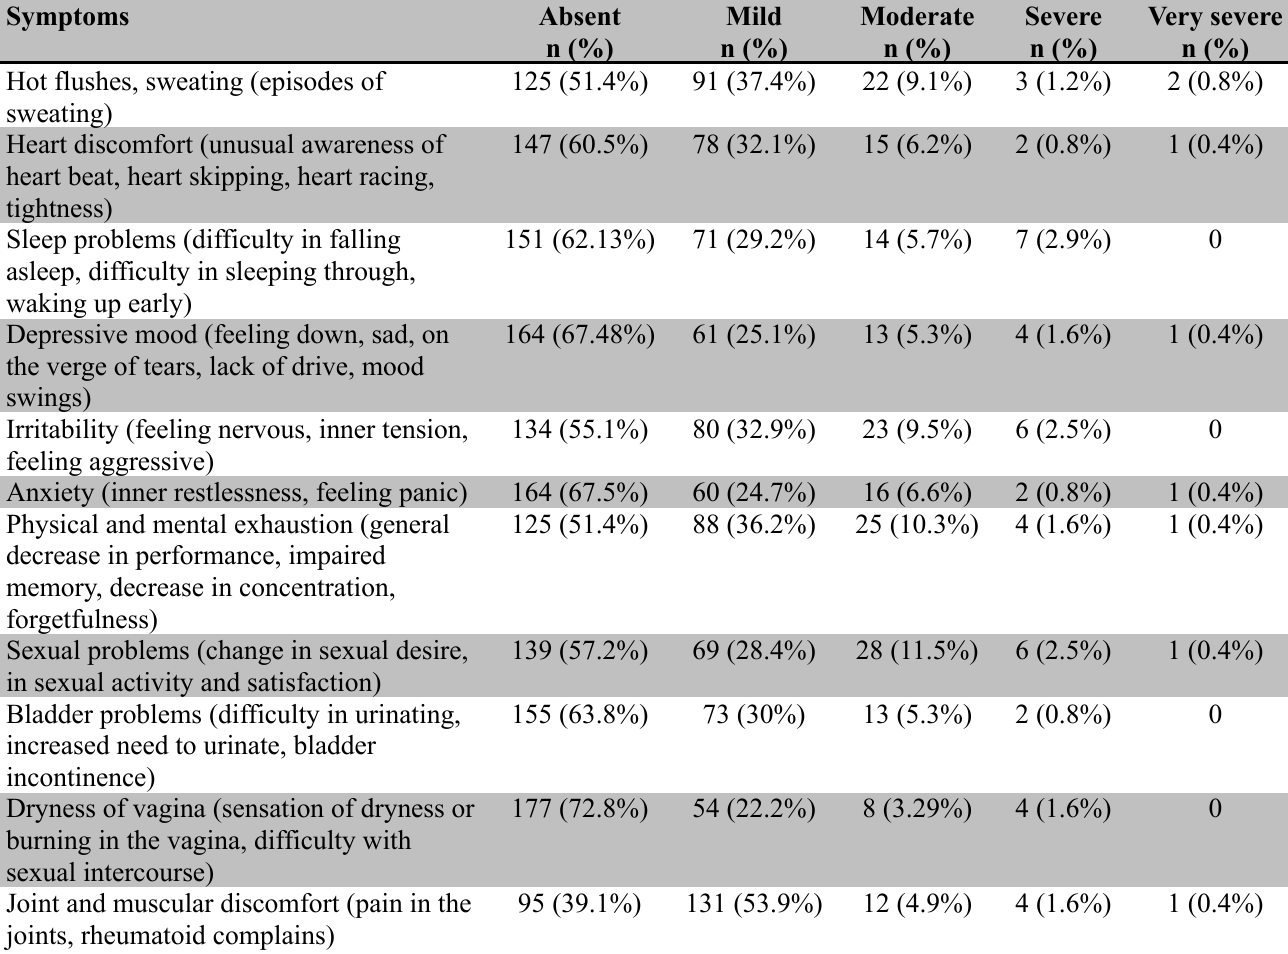
Mild Moderate Severe Very severe n (%) n (%) n (%) n (%) n (%)